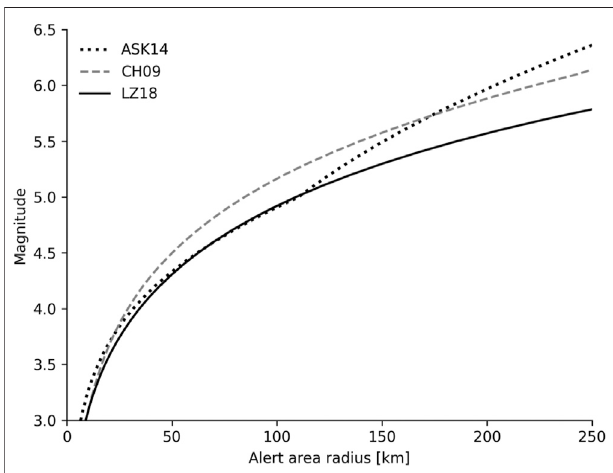
FIGURE7| MagnitudeasafunctionofalertradiusforaPGAthresholdof 2 cm/s 2 (MMI II-III) using LZ18 (black solid line), ASK14 (black dotted line) and CH09 (gray dashed